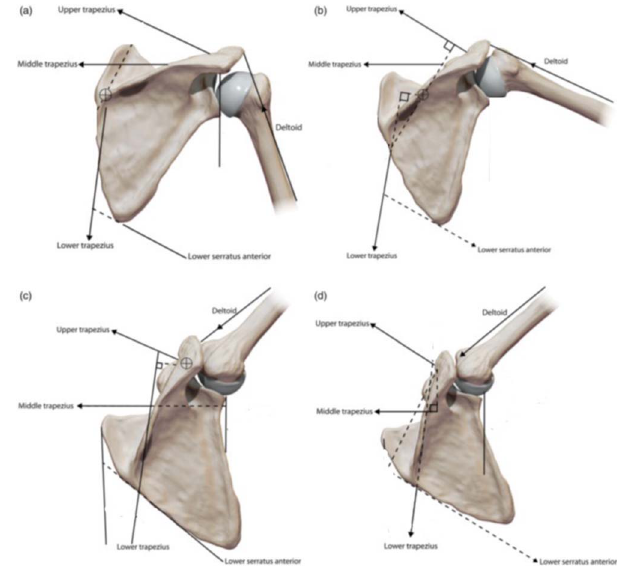
Figure 1. The scapular movement in relation to humeral abduction and the corresponding muscle vectors that affect